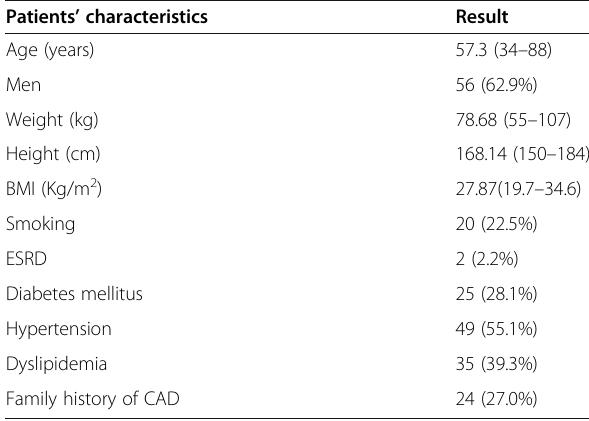
Table 1 Patients ’